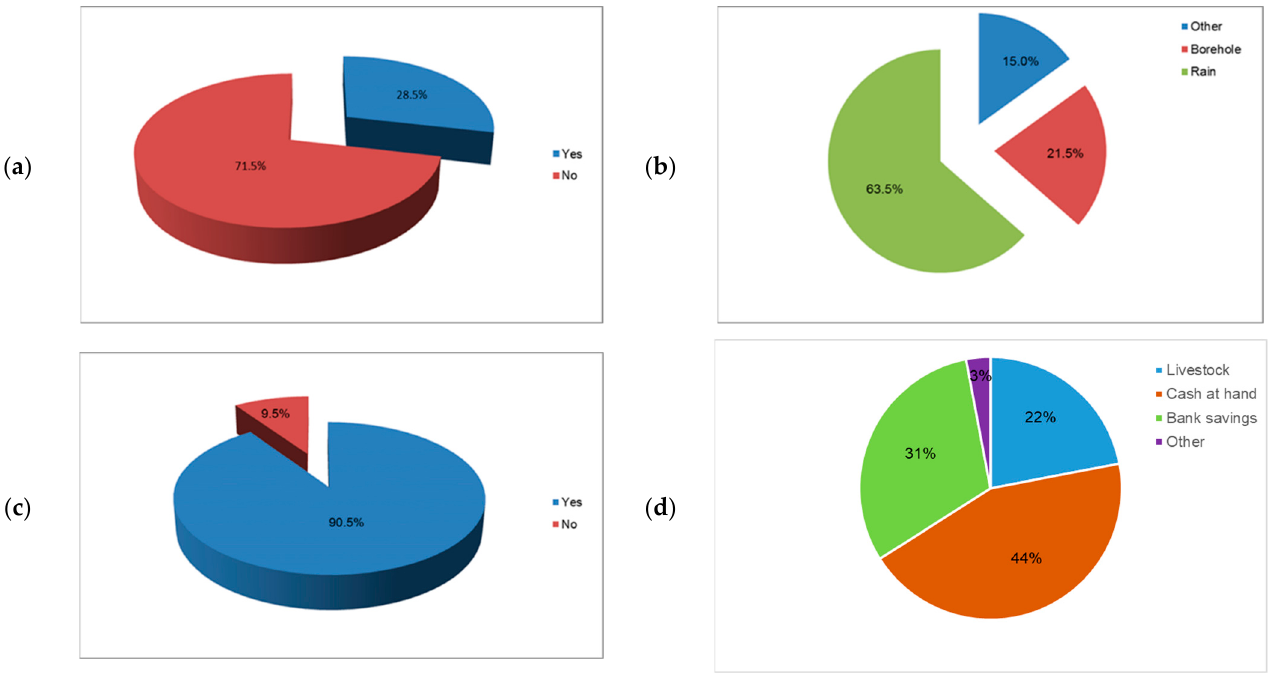
Figure 3. Smallholder farmers ( a ) water source, ( b ) employment status, ( c ) access to credits, and ( d ) saving money in study area ( n = 200).